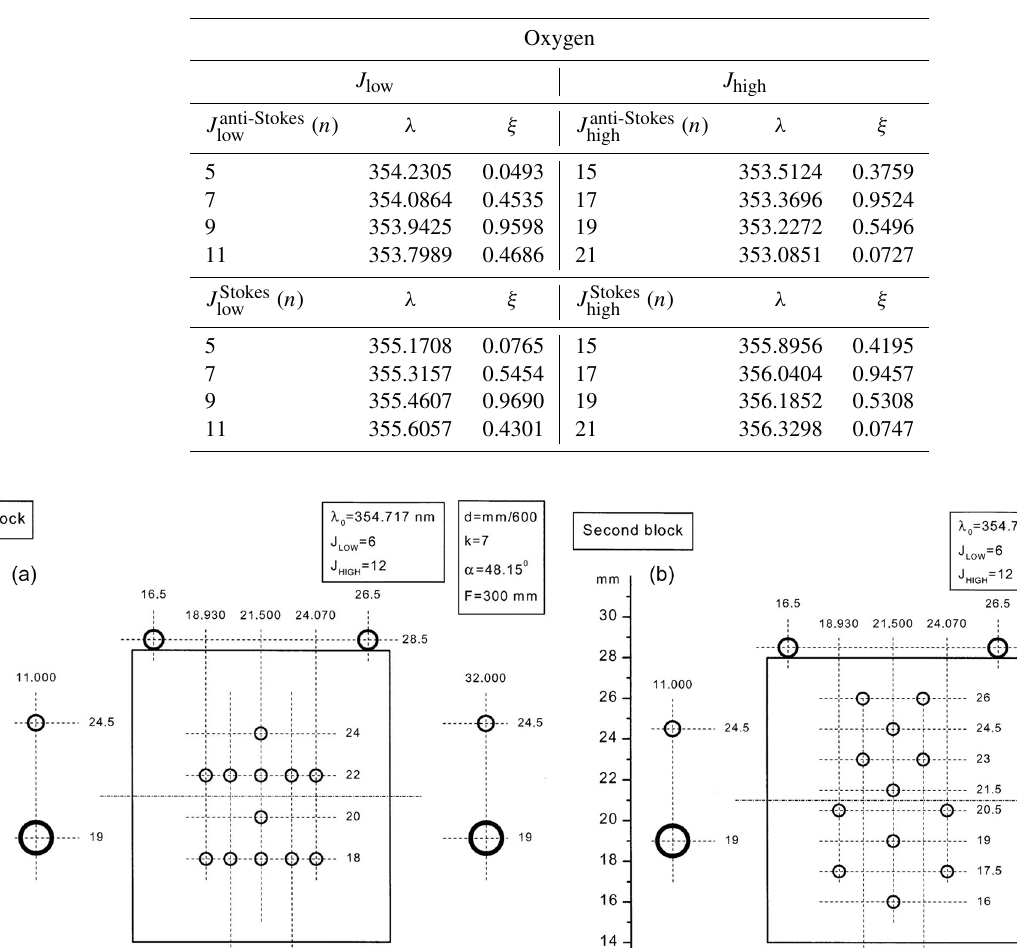
Table 2. Theoretical polychromator efficiencies ( ξ ) for the oxygen PRR lines at wavelengths λ .